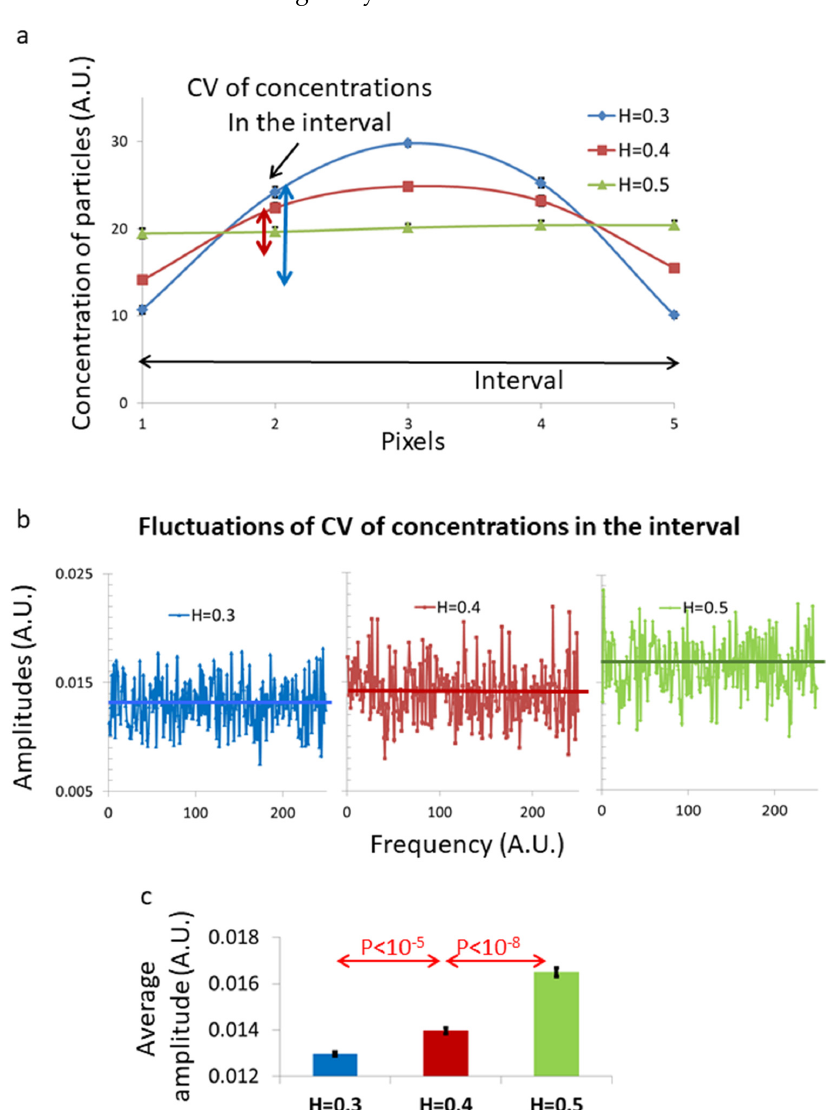
Figure 5a, the spatial distributions of multiple particles inside an interval depend on the standard deviation (SD) of the particles’ concentration along the length of the interval, relative to the average particle concentration or the total number of particles. The coefficient of variation (CV) describes that relation and defines the spatial inhomogeneity in the interval with no dependence on different average concentrations of particles inside the interval. The CV value of each fBM simulated process was calculated 500 times (each fBM process consists of 100 diffusion steps) and the fluctuation of CV values was analyzed. As can be seen in Figure 5b,c, the amplitude of fluctuations of the CV measure is dependent on the corresponding H values. As expected, low H values relate to lower amplitudes of fluctuations in the inhomogeneity inside the fBM interval.